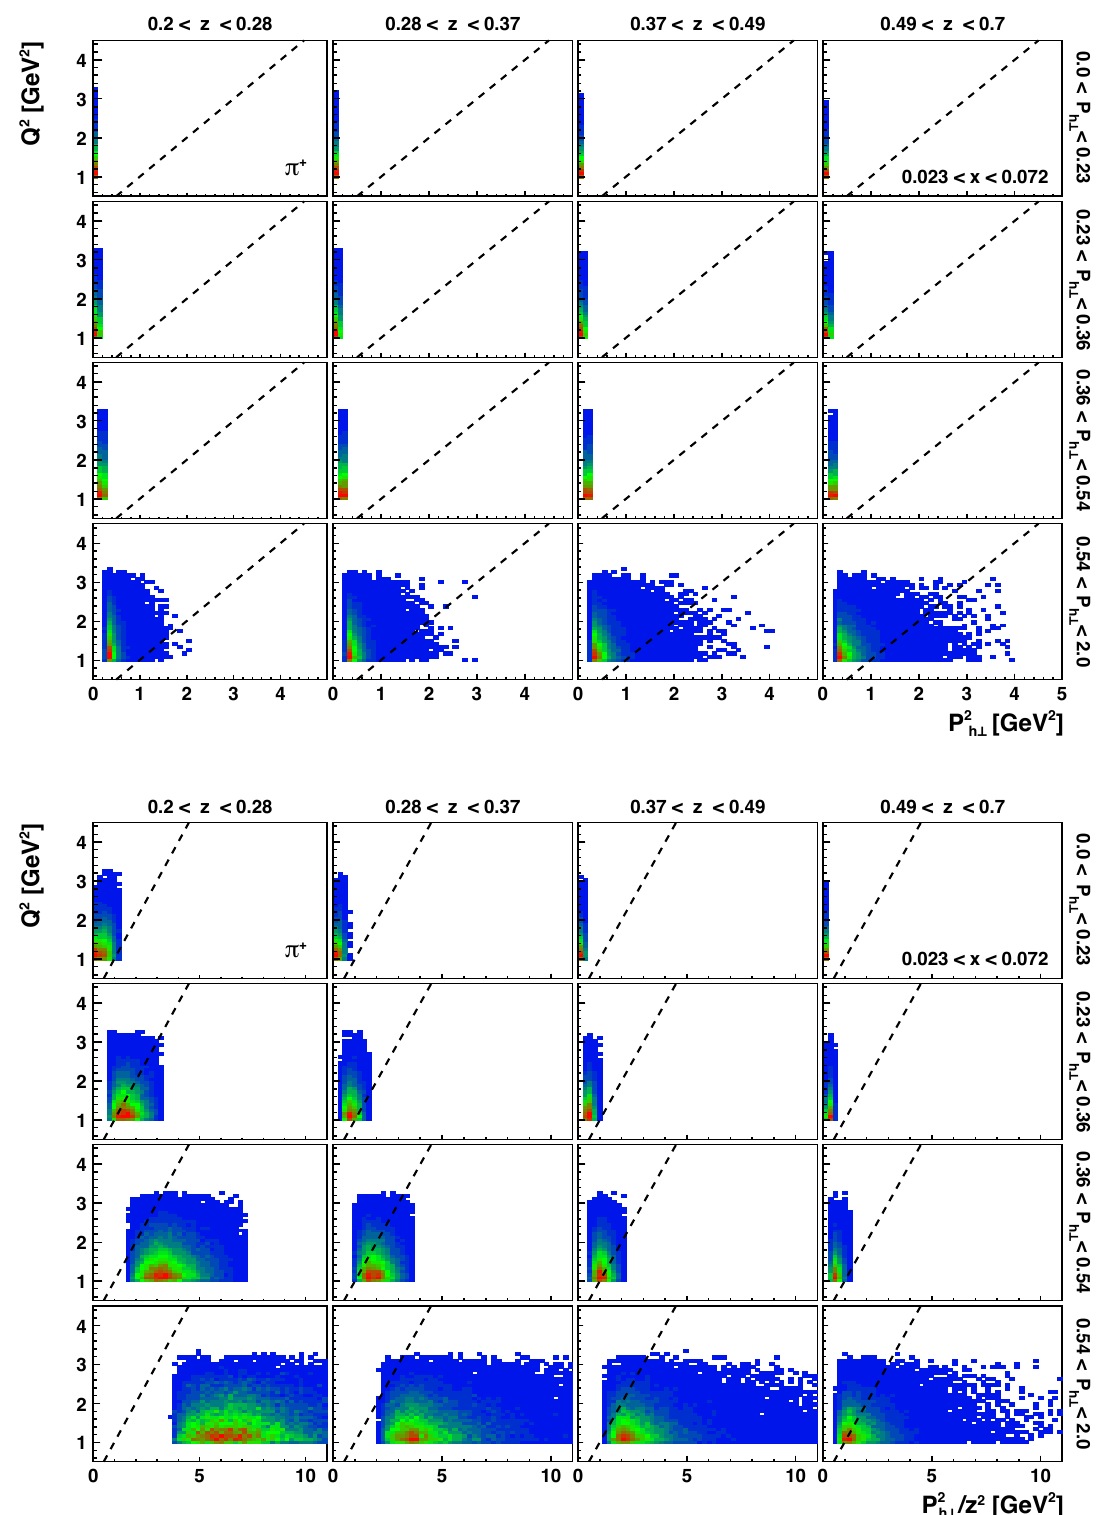
Figure 44 . The distribution of π + events in the Q 2 – P 2 for the various ( z , P h ⊥ ) bins of the lowest x bin. The Q 2 = P 2 boundaries are indicated by dashed